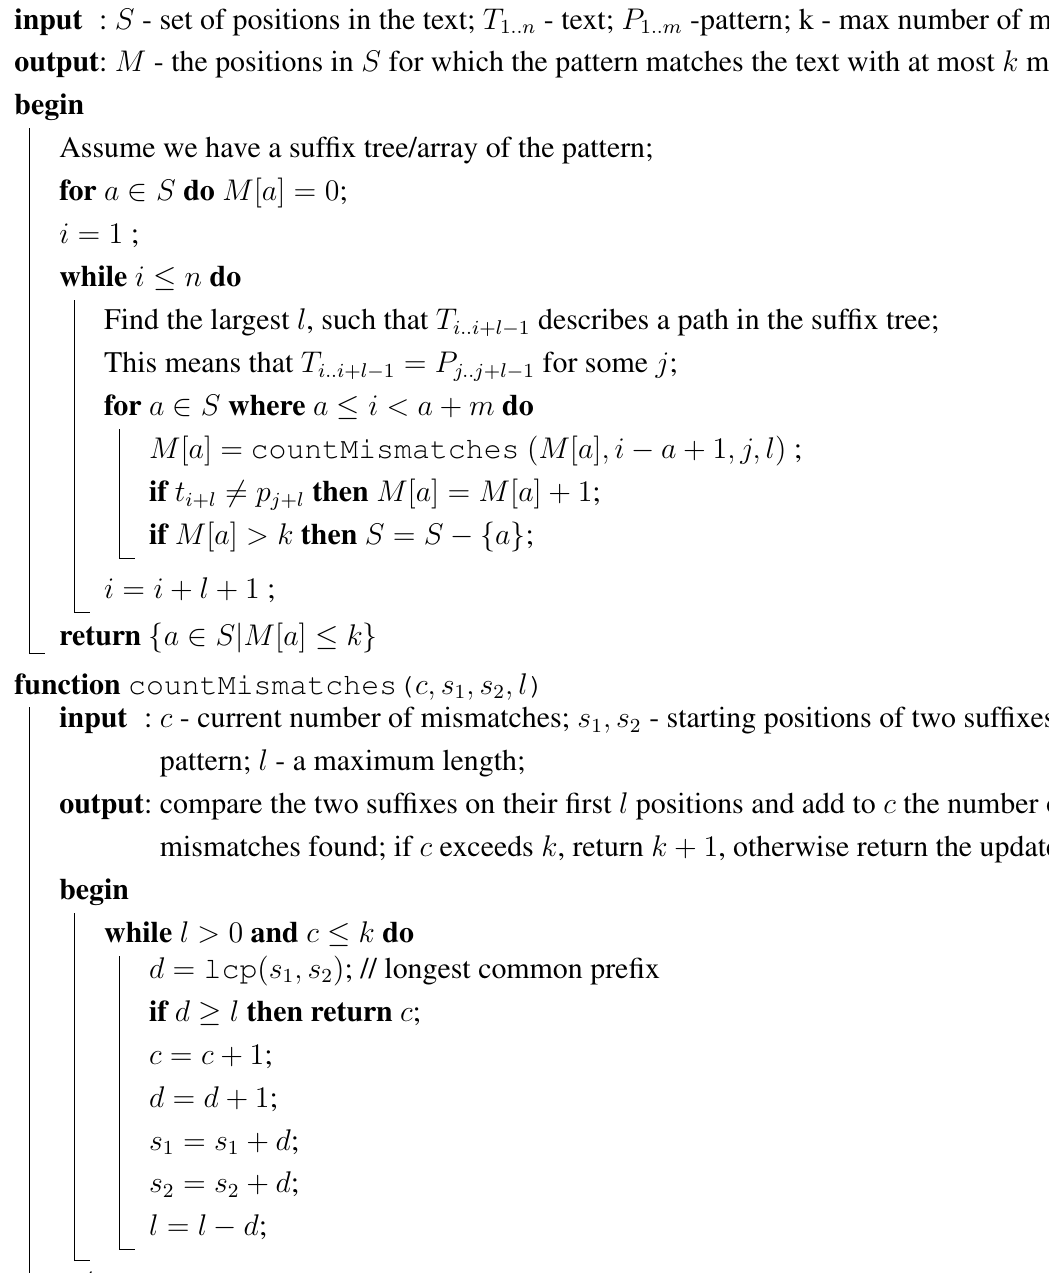
Algorithm 2: Subset k mismatches( S, T, P, k